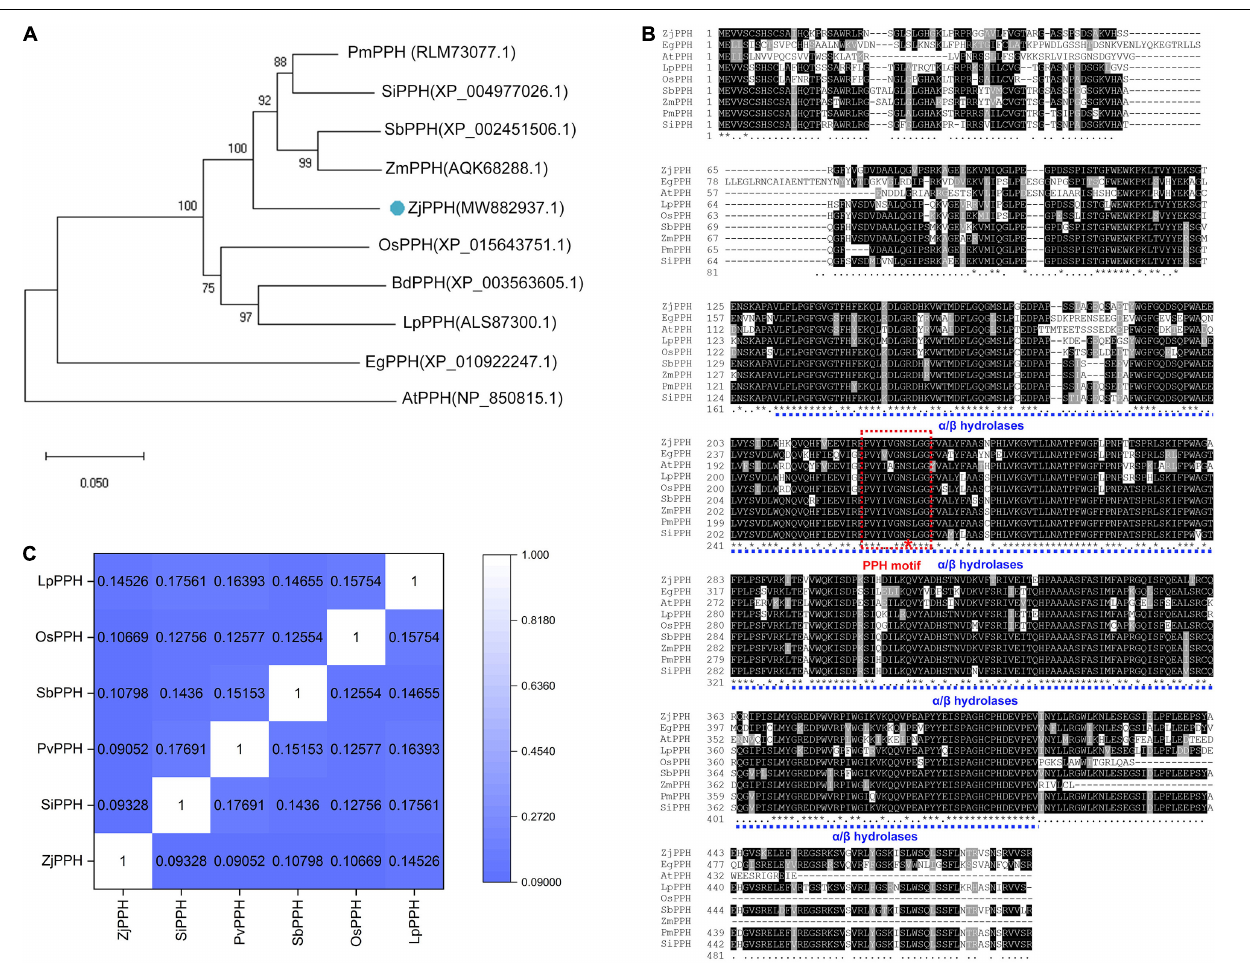
FIGURE 1 | Bioinformatic analysis of ZjPPH . (A) Phylogenetic tree: orthologous proteins in Panicum miliaceum (PmPPH), Setaria italica (SiPPH), Sorghum bicolor (SbPPH), Zea mays (ZmPPH), Zoysia japonica (ZjPPH), Oryza sativa (OsPPH), Brachypodium distachyon (BdPPH), Lolium perenne (LpPPH), Elaeis guineensis (EgPPH), and Arabidopsis thaliana (AtPPH) were used for analysis. (B) Multiple sequences alignment and conserved domain prediction. (C) Ka/Ks